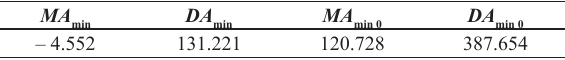
Table 1. Mathematical expectation and variance of the mini- mum negative amplitude half-wave value at the TIBR input.